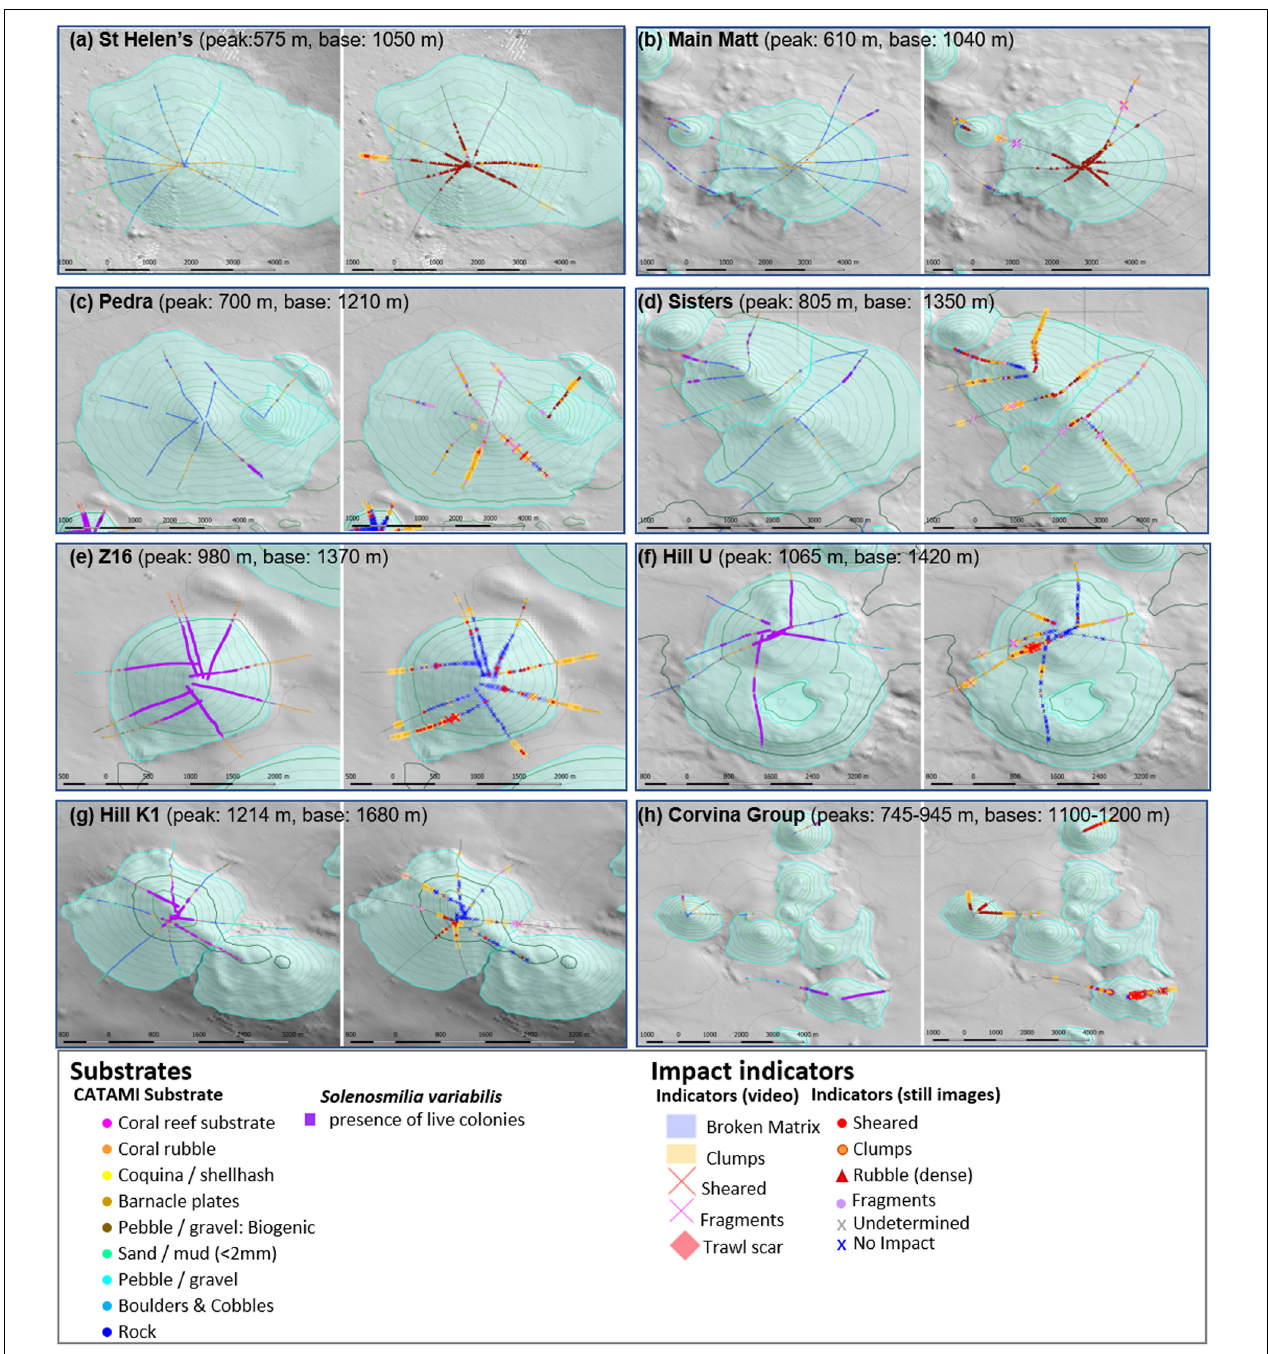
FIGURE 6 | The eight Focal areas sampled with multiple transects showing detailed mapping of impact indicators, substratum types and distribution of live coral matrix. Their locations are shown in Figure 1 . Supplementary Figure 1 shows example detail of the four annotation types for Hill U and expanded images to show detail for all Focal areas are shown in Supplementary Figure 2 . Most focal areas contain individual seamounts, although Pedra has a parasitic cone (Mongrel) and Main Matt has a second peak (NW Matt); the Corvina Group has six inter-connected seamounts: (a) St Helens, (b) Main Matt, (c) Pedra, (d) Z16, (e) Corvina Group, (f) Hill U, (g) Sisters, and (h) Hill